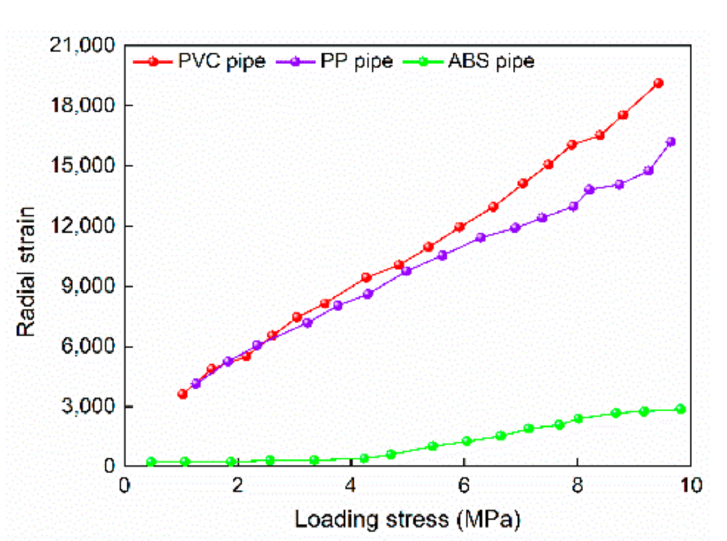
Figure 5. Variation curves of radial strains and loading stress of PVC, ABS, and PP screen pipes.